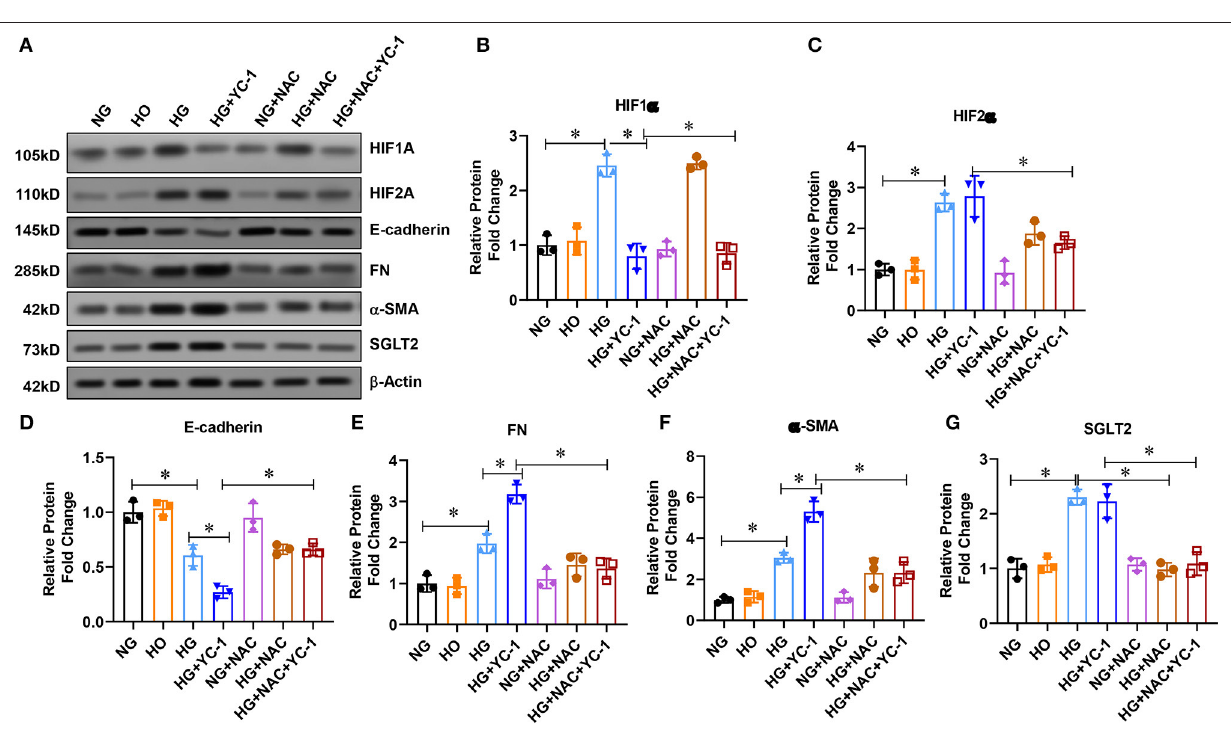
FIGURE 5 | HIF-1 α reduced epithelial-mesenchymal transition (EMT) in HK-2 cells subjected to HG exposure. (A–G) . Western blot analysis revealed that FN and a-SMA were significantly increased, while E-cadherin expression was significantly decreased in HK-2 cells subjected to HG conditions. EMT, Epithelial-Mesenchymal Transition; HG, High Glucose; FN, Fibronectin; A-SMA, Alpha-Smooth Muscle